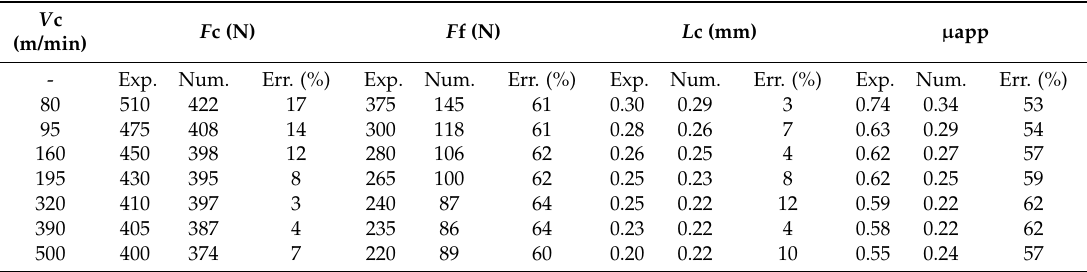
Table 6. Comparison between experimental data and ALE ‐ FE results.